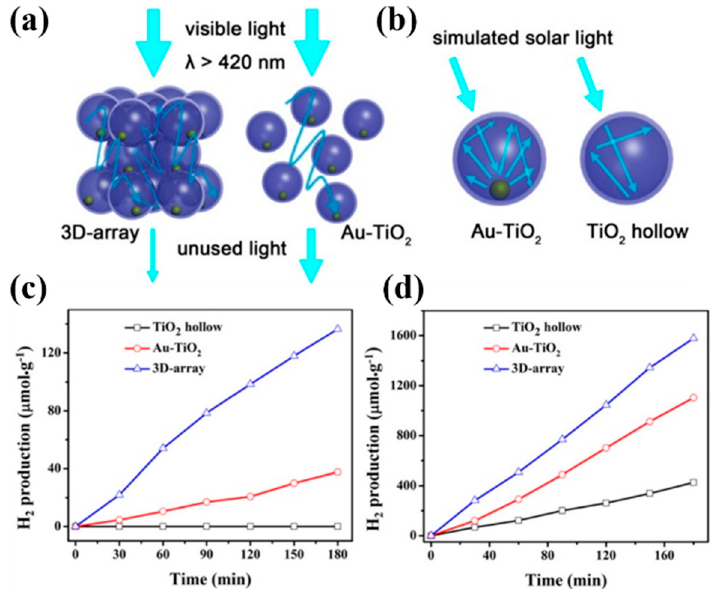
Figure 6. The scheme of the pathway of light in ( a ) 3D-array Au-TiO 2 hollow structures and random distributions of Au-TiO 2 under visible light illumination (>420 nm), and ( b ) in single Au-TiO 2 hollow and TiO 2 hollow structures under simulated daylight. The comparison of the amounts of H 2 production in three typical structures under ( c ) simulated daylight and ( d ) visible light illumination (>420 nm). Reproduced with permission. [82] Copyright 2016, American Chemical Society.